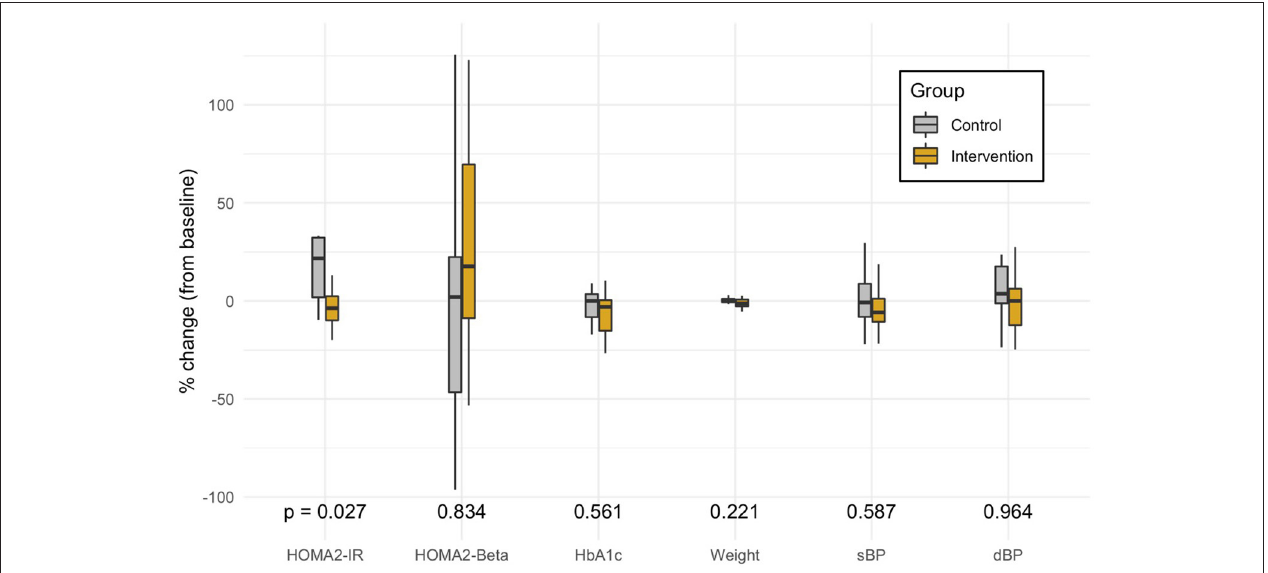
FIGURE 3 | Distribution of the percent change in each primary and secondary outcome variable from adjusted multivariate models. The box marks the median and first and third quartiles of the distribution; the whiskers extend up to 1.5 x IQR. P -values are from the multivariate model controlling for race, years of type 2 diabetes, stage of change, food access, and Medicaid status. HOMA, Homeostatic Model Assessment; IR, Insulin Resistance; Beta, estimate of pancreatic beta cell function; EVS, Exercise Vital Signs (minutes of exercise per week); HbA1c, Glycated Hemoglobin; sBP, Systolic Blood Pressure; dBP, Diastolic Blood